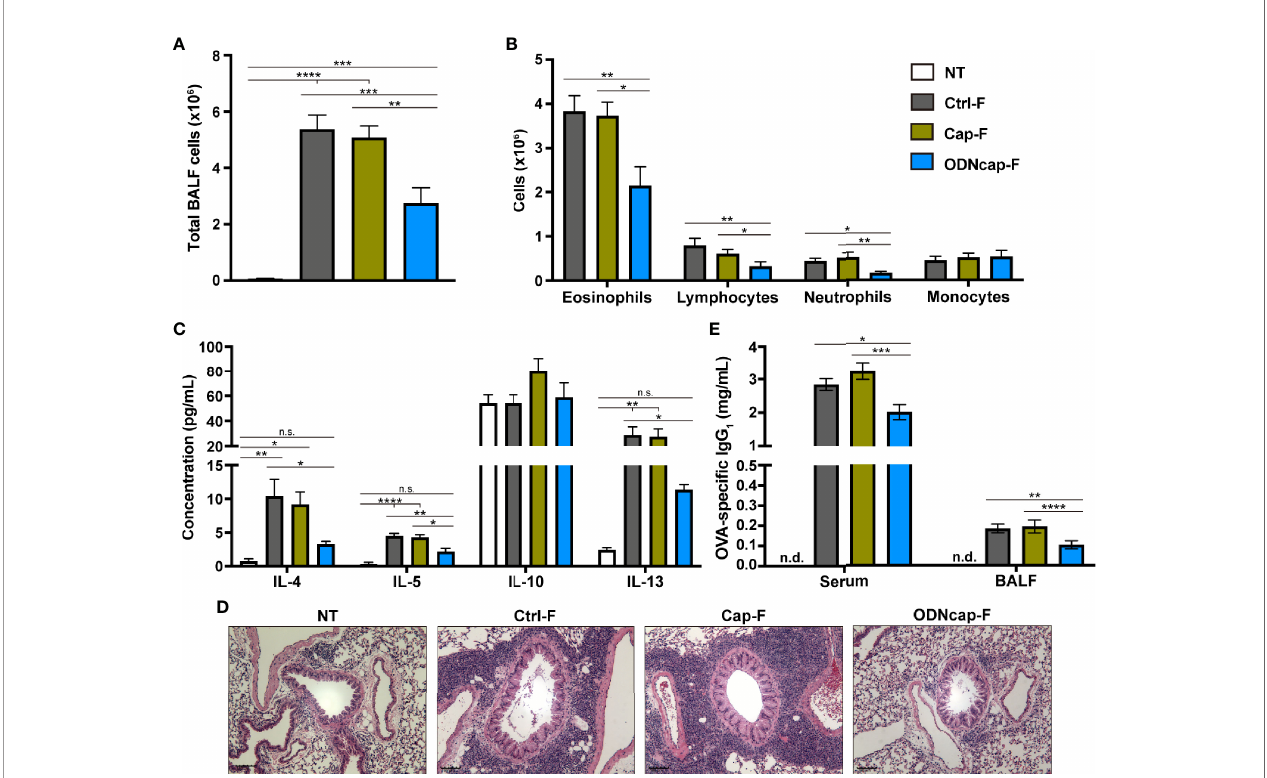
FIGURE 2 | ODNcap-F attenuates allergic airway in fl ammation. Bronchoalveolar lavage fl uid (BALF), serum, and lung sections were prepared on Day 70. (A) Total BALF cells were counted by trypan blue staining ( n = 12). (B) Flow cytometric analysis was performed to determine the proportions of eosinophils, neutrophils, lymphocytes, and monocytes in BALF ( n = 12). (C) BALF levels of cytokines were measured by enzyme-linked immunosorbent assay ( n = 6). (D) Representative images of hematoxylin-eosin-stained sections ( n = 6). Scale bars, 100 m m. (E) Serum and BALF levels of ovalbumin (OVA)-speci fi c immunoglobulin G 1 (IgG 1 ) were measured by enzyme-linked immunosorbent assay ( n = 12). n.d., not detected. Data are shown as the mean ± standard error of the mean. **** P < 0.0001; *** P < 0.001; ** P < 0.01; * P < 0.05; n.s., not signi fi cant by two-tailed one-way analysis of variance and post hoc Tukey ’ s